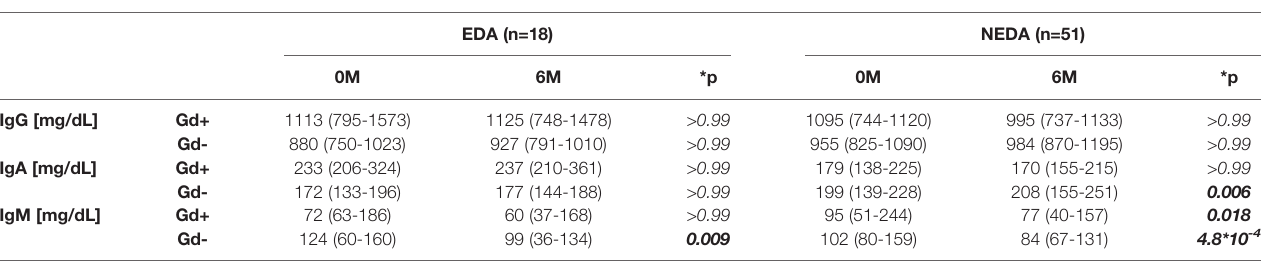
TABLE 3 | Ocrelizumab induced changes in serum immunoglobulin